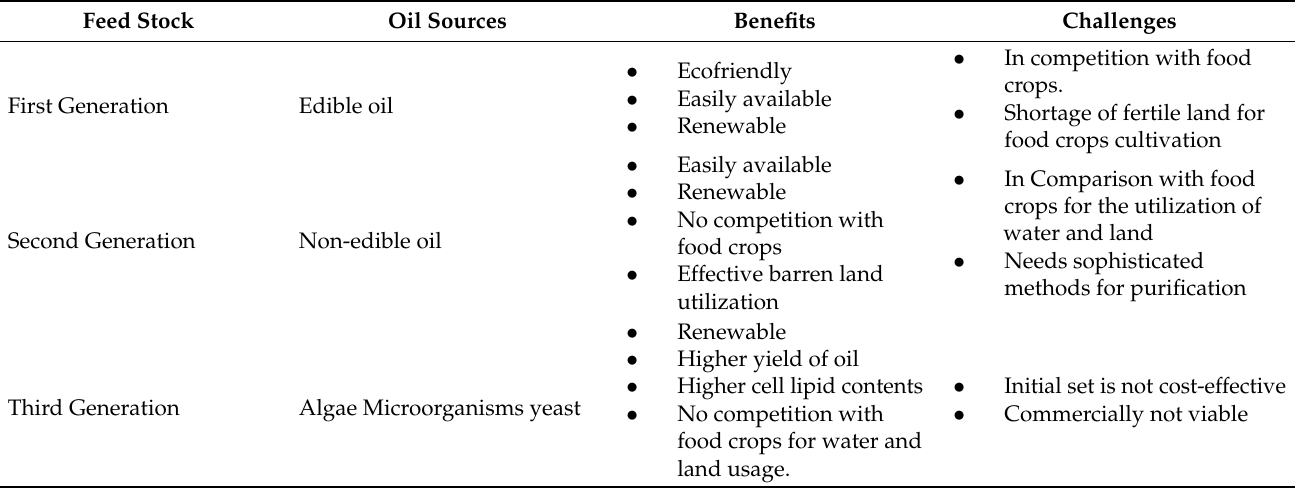
Table 1. Summary of advantages and disadvantages of different feedstock oils used for the synthesis of biodiesel. Feed Stock Oil